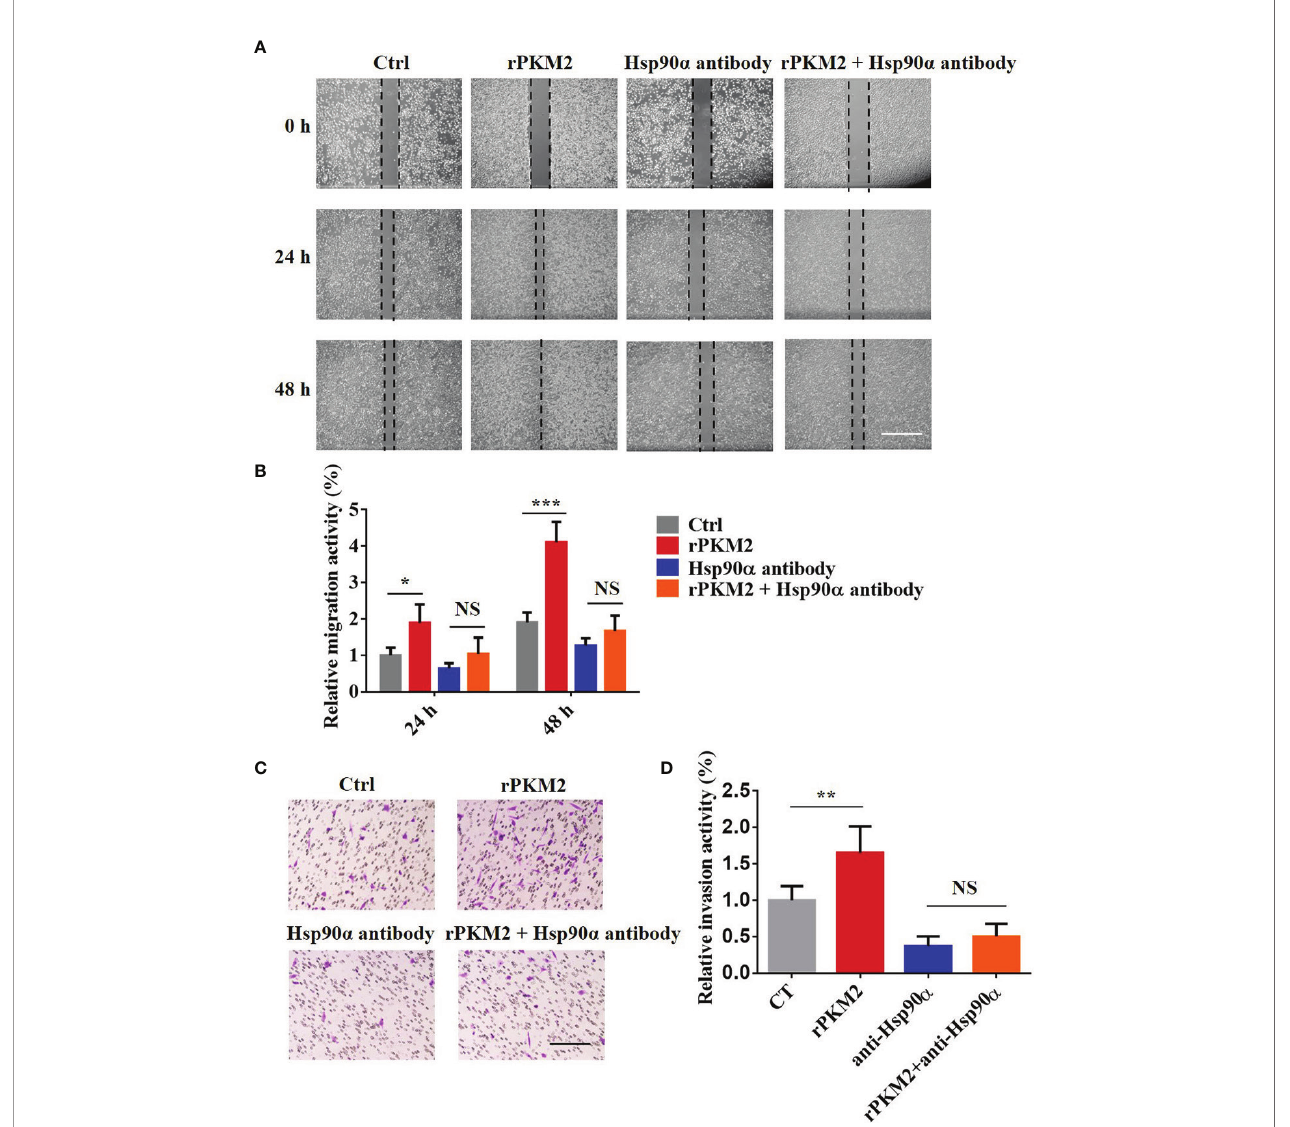
FIGURE 3 | Extracellular PKM2 promotes tumor migration and invasion dependent on extracellular Hsp90 a . (A) Representative images of A549 migration assay (scale bar, 200 m m) with PBS, rPKM2, anti-Hsp90 a , or anti-Hsp90 a and rPKM2 together. (B) Quanti fi ed results of A549 migration assay with PBS, rPKM2, anti- Hsp90 a , or anti-Hsp90 a and rPKM2 together. (C) Representative images of A549 invasion assay (scale bar, 200 m m) with PBS, rPKM2, anti-Hsp90 a , or anti- Hsp90 a and rPKM2 together. (D) Quanti fi ed results of A549 invasion assay with PBS, rPKM2, anti-Hsp90 a , or anti-Hsp90 a and rPKM2 together. Data are represented as mean ± SD. NS, not signi fi cant; * p < 0.05; ** p < 0.01, *** p < 0.001, two-tailed Student ’ s t tests; n = 3 biological